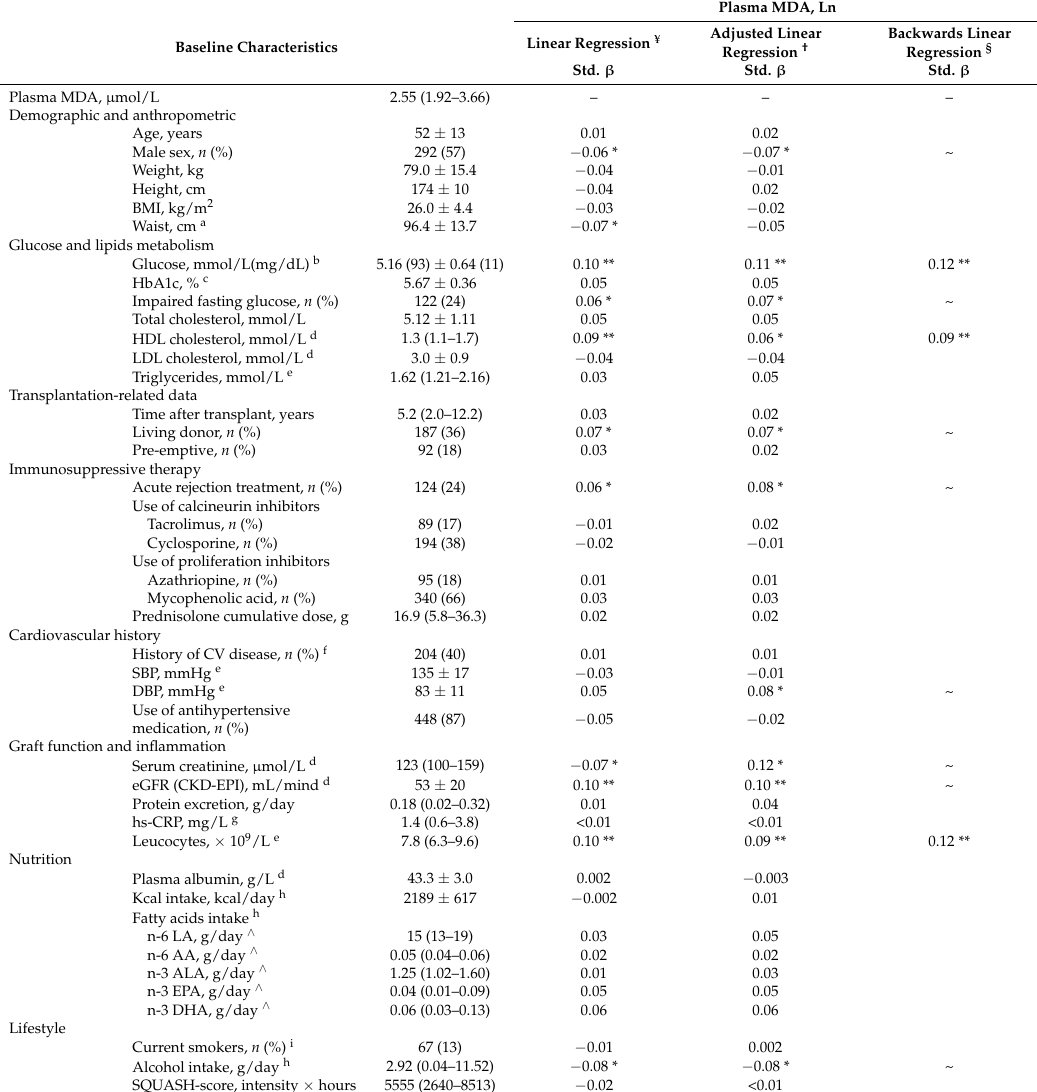
Table 1. Baseline characteristics of the study population and its association with circulating malondialdehyde (MDA) ( n =